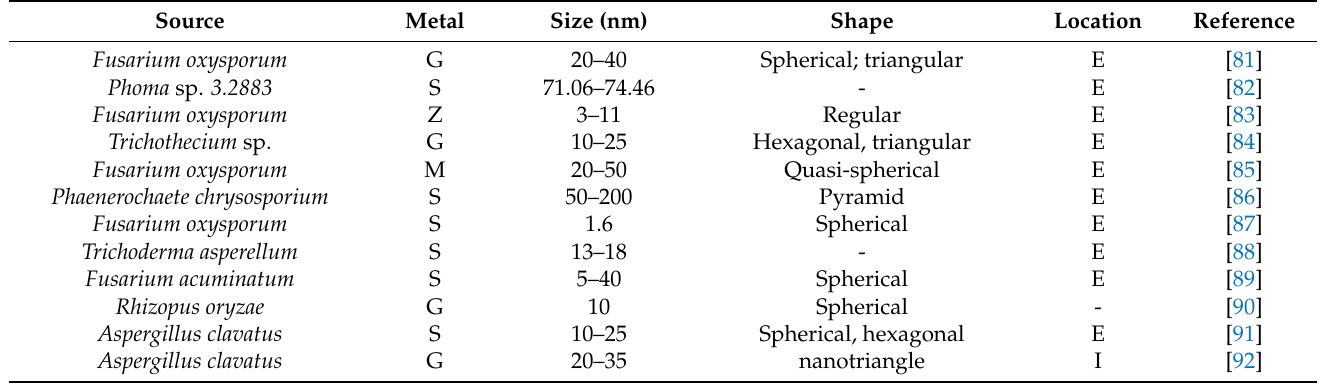
Table 2. Nanoparticles synthesized from